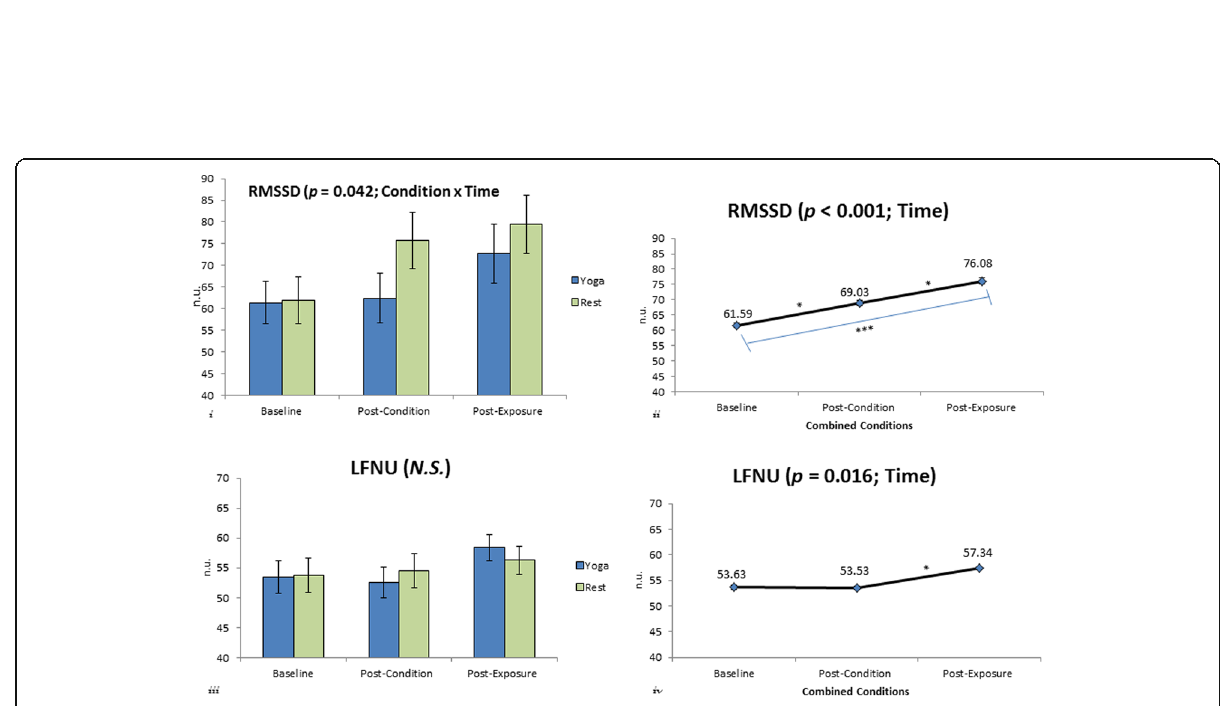
Fig. 3 (i) Root Mean Square of Successive Differences in RR Intervals (RMSSD) at baseline, post-condition and post-exposure for the yoga and rest conditions. Significant condition x time interaction , * p = 0 .042. (ii) Combined RMSSD at baseline, post-condition and post-exposure. Significant increase between baseline and post-condition (p = 0 .019 ), post-condition and post-exposure (*p = 0 .007), and between baseline and post- exposure ,*** p < 0 .001. (iii) Low-frequency power in normalized units (LFN) at baseline, post-condition and post-exposure for the yoga and rest conditions. No significant difference between the yoga and rest conditions. (iv) Combined LFN at baseline, post-condition and post-exposure. Significant increase, * p = 0 .008 , between post-condition and post-exposure. Note symbols or abbreviations on graphs: N.S.- not significant, *p < 0 .05, **p = 0 .001, and ***p< 0 .001. Error bars =